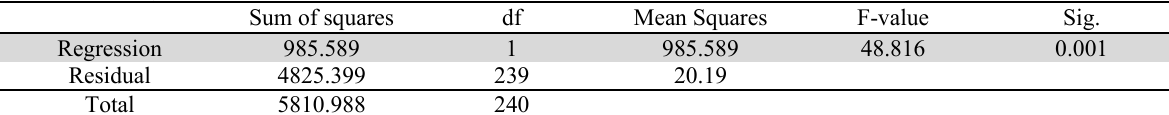
The summary of ANNOVA